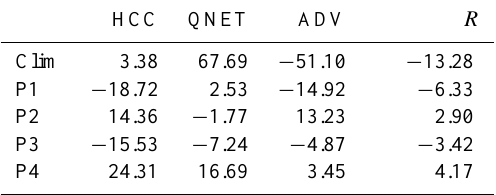
Fig. 2. Temperature anomalies of the whole South China Sea (con- Figure 2 .Temperature anomalies of the whole South China Sea (contour interval: 0.2, 327 tour interval: 0.2, units: K; seasonal cycle removed) of the XBT units: K; seasonal cycle removed) of the XBT (top) and SODA (middle), and the 328 (top) and SODA (middle), and the heat-content time series of XBT heat-content time series of XBT and SODA (bottom), units: 10 23 J. Also indicated are 329 and SODA (bottom), units: 10 23 J. Also indicated are P1: 1958– P1: 1958-1968; P2: 1969-1981; P3: 1982-1992; and P4: 1993-2003. 330 1968; P2: 1969–1981; P3: 1982–1992; and P4: 1993–2003. Table 1. The terms of heat budget for the climatological mean and in the four periods shown in Fig. 2. HCC denotes heat-content change in the upper 400m. QNET (positive into the SCS) denotes the net surface heat flux. ADV (positive into the SCS) is the ocean heat ad- vection, and R is the residual heat flux (vertical advection, diffusion, etc.). Units: TW, where 1 TW = 10 12 W.